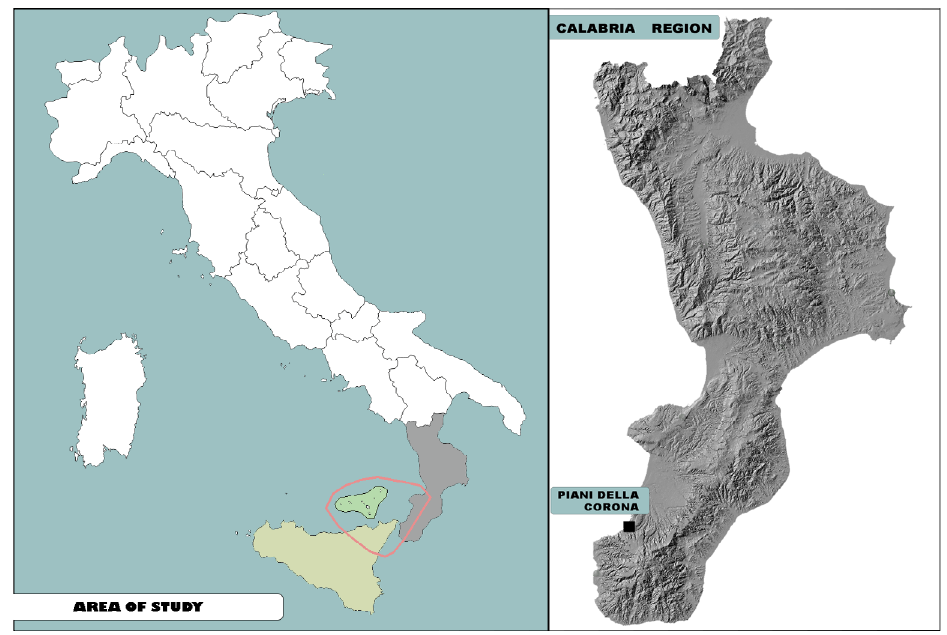
Figure 1. Geographical positioning of Piani della Corona EBA settlement (Bagnara Calabra,